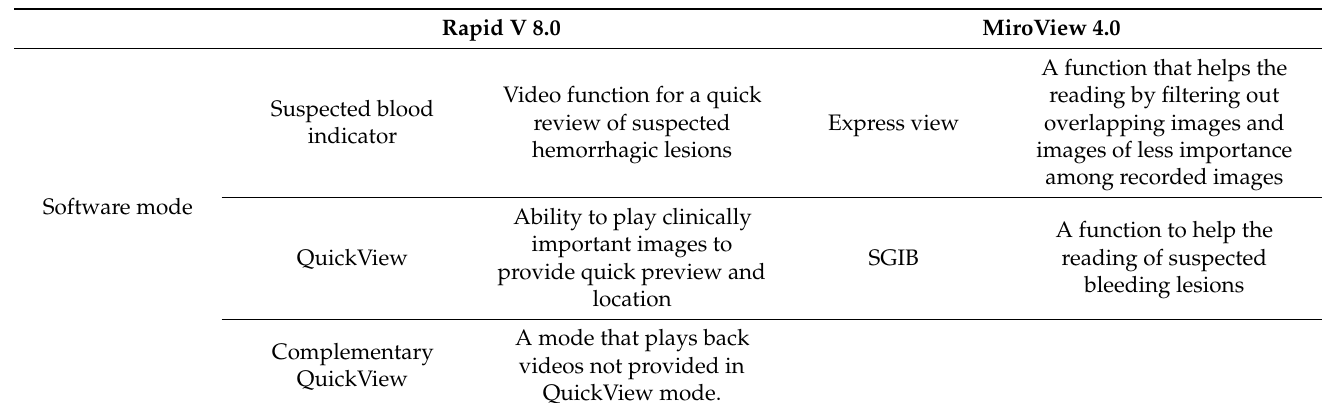
Table 3. Comparison of software